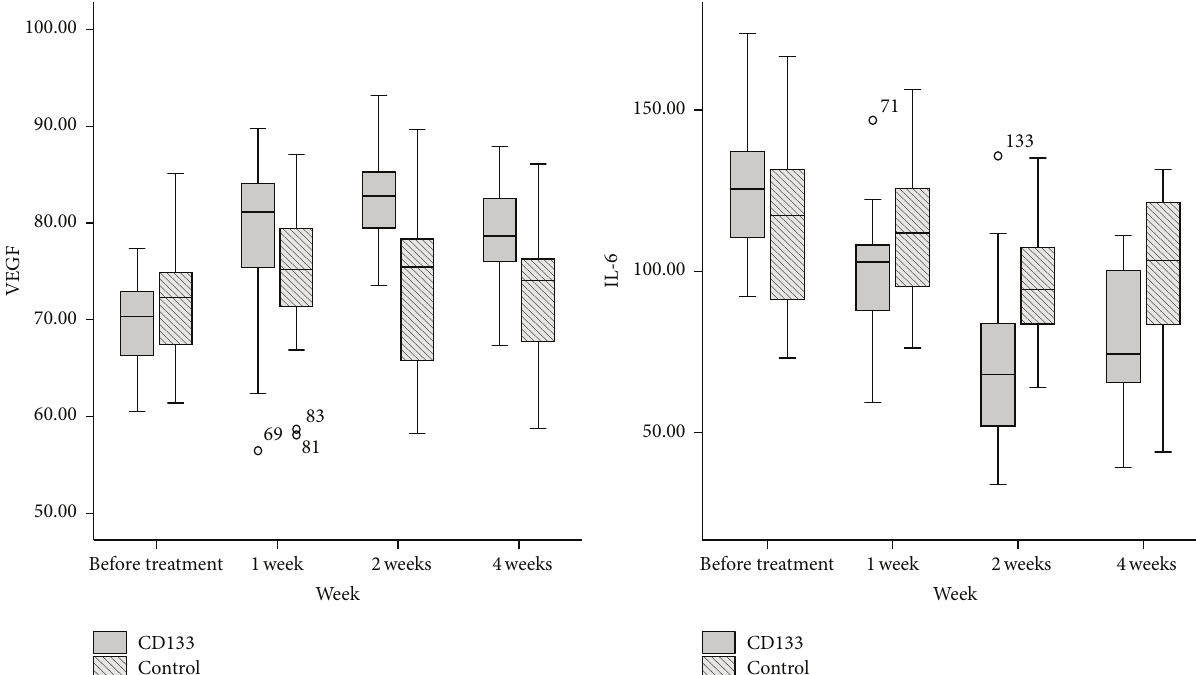
Figure 3: Serum VEGF and IL-6 level change within 4 weeks after treatment. CD133 + group had a significant increasing VEGF and decreasing IL-6 level than the control since the first week after treatment, and this significance seemed to become weaker from the 4th week after treatment. “ ∘ ” represents mild outliers in boxplot, and the small numbers beside it represent the case numbers.